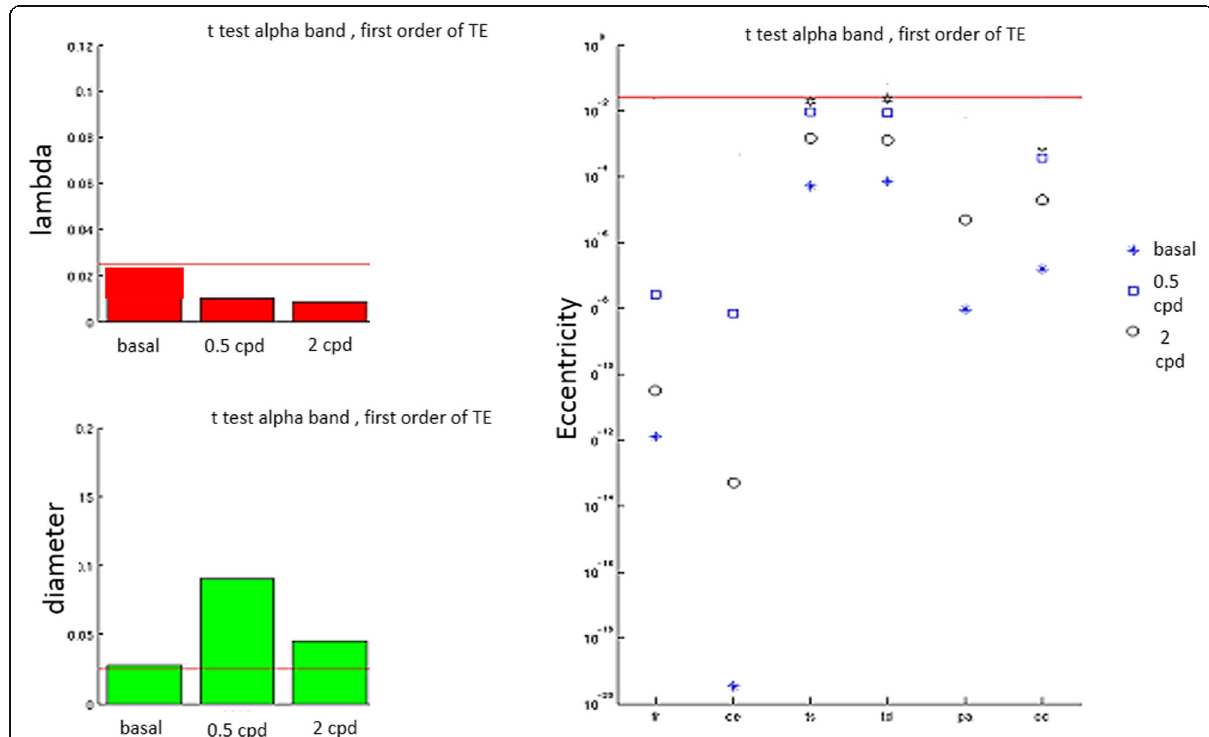
Fig. 6 ANOVA tests on Characteristic Path Length features of Migraine with Aura versus Migraine Without Aura. The first column shows the Student t-test on the “ lambda ” and “ diameter ” factors (which stem for the medium path length and its distribution) in basal condition and during 0.5 cpd and 2 cpd spatial frequency visual stimulation. The lambda is clearly smaller for MA, as one can argue observing the “ eccentricity ” (distribution of the minima, right column) at all the stimulations and for all cortical bands (alpha band is here represented). The red horizontal line stems for the t-test confidence level (Bonferroni corrected) under which the probability of having distinct population is